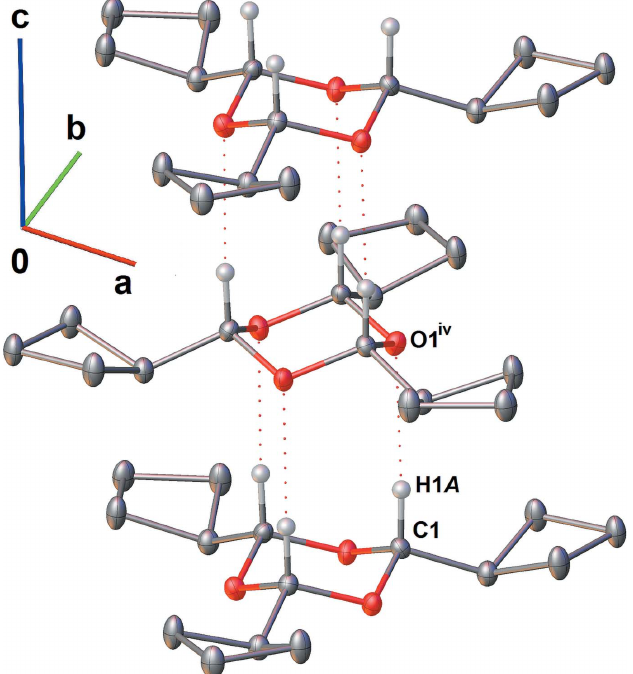
Figure 3 A fragment of the infinite stacks formed by molecules of 1 along the c - axis direction. Hydrogen atoms except those of the 1,3,5-trioxane rings are omitted for clarity. Red dashed lines represent intermolecular C— H (cid:3)(cid:3)(cid:3) O interactions (Table 1).